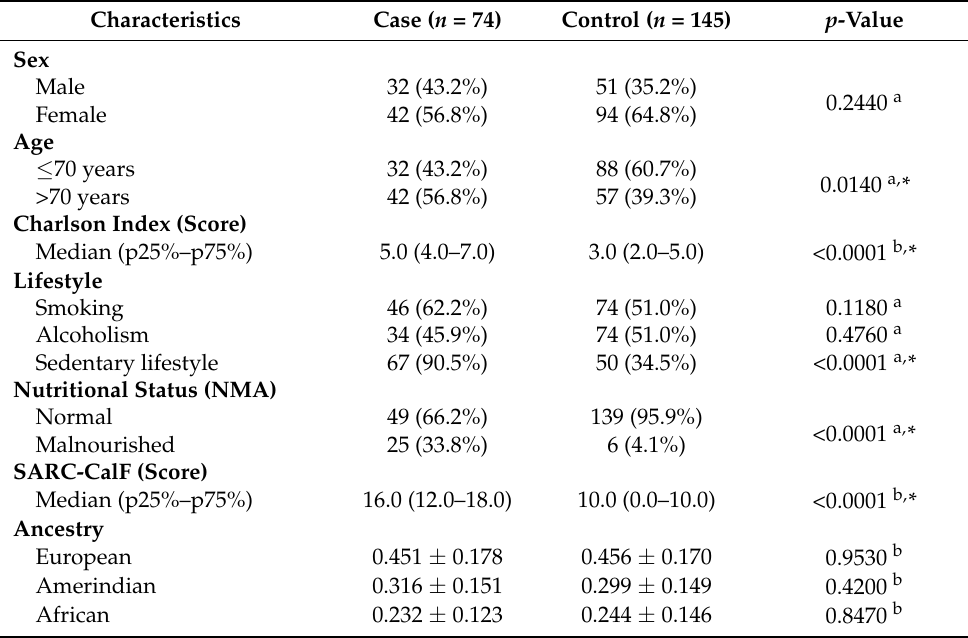
Table 1. Demographic and clinical characteristics of the investigated groups.